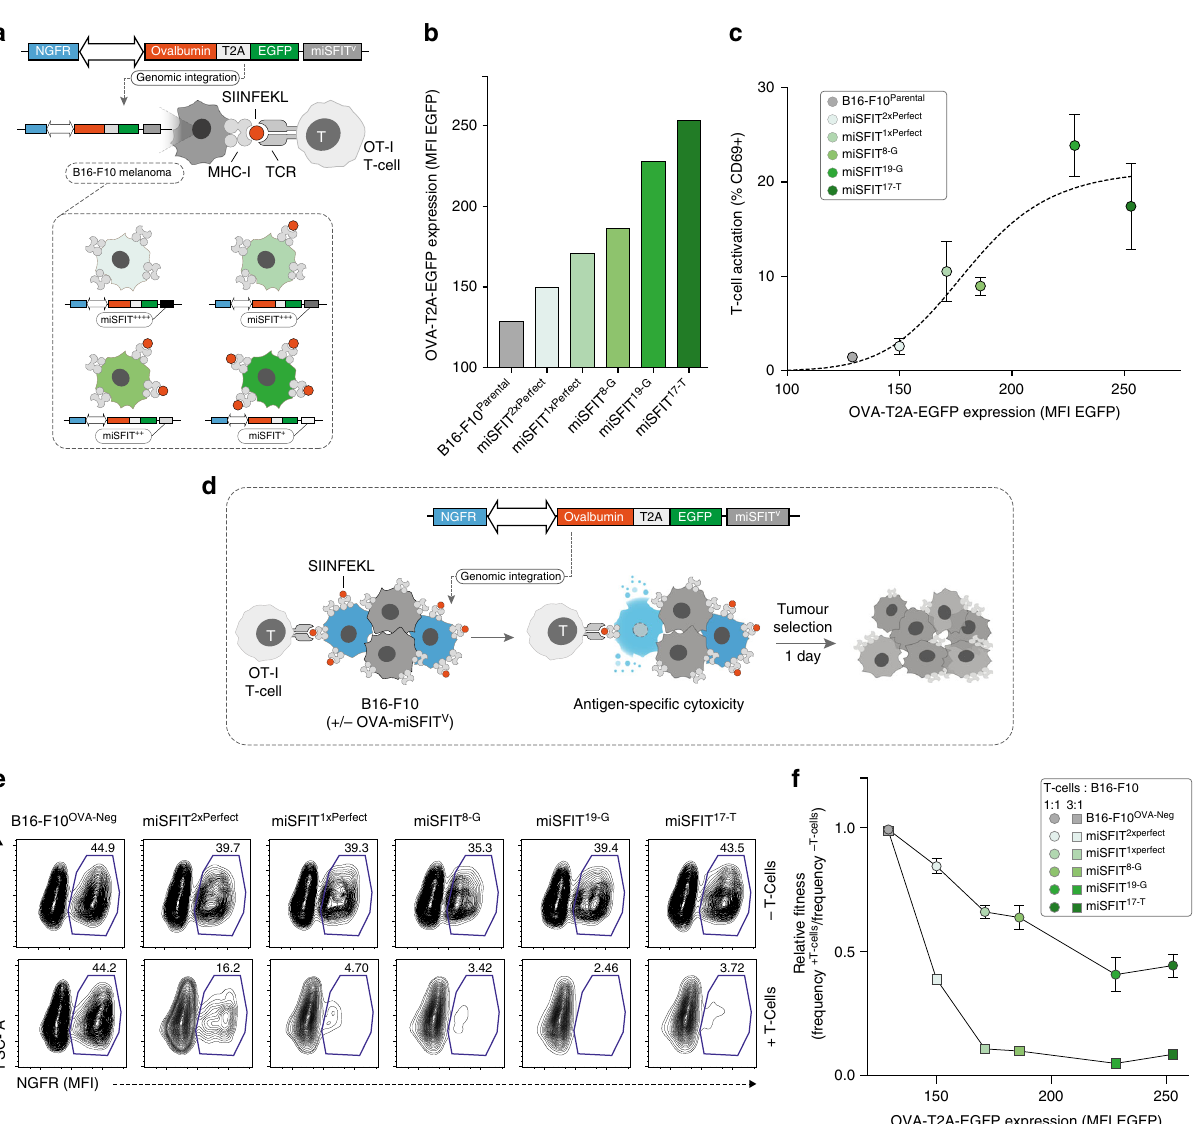
Fig. 3 Fine-tuning antigen expression levels and T-cell activity. a Strategy for tuning Ovalbumin (OVA) expression in B16-F10 melanoma cells using lentivirally integrated miSFITs. Red circles represent SIINFEKL, a peptide antigen derived from ovalbumin. OT-I T-cells express a TCR speci fi c for SIINFEKL presented on MHC-I. b Flow cytometry analysis of OVA-T2A-EGFP expression in B16-F10 cell lines transduced with six different miSFIT variant (miSFIT V ) lentiviruses (see Supplementary Figure 6 for the gating strategy and distribution of fl uorescence intensity) c CD8 + , OT-I T-cell activation by OVA-miSFIT B16-F10 cell lines. CD69 expression was quanti fi ed by fl ow-cytometry ( n = 5 biological replicates, mean + / − s.d.). d Schematic representation of mixed- culture experimental design. OVA-negative (NGFR - ) are mixed with OVA-miSFIT (NGFR + ) B16-F10 cells and are challenged overnight with OT-I T-cells. e Representative fl ow cytometry plots of mixed culture experiments. The percentage of NGFR + (OVA-miSFIT) cells (blue polygon gate) surviving after overnight selection in the presence or absence of CD8 + , OT-I T-cells(at a ratio of 3:1 T-cells to B16-F10 cells) is indicated for each condition. f Relative fi tness of B16-F10 cell lines as a function of OVA expression. Relative fi tness was calculated by dividing the frequency of NGFR + cells with T-cells by the frequency of NGFR + cells without T-cells ( n = 3 biological replicates, mean + / − s.d.). Source data are provided as a Source Data fi